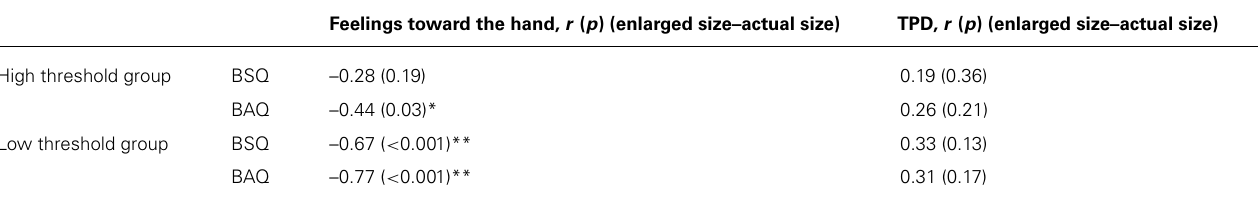
Table 3 | Correlation among BSQ score, BAQ score, variation of Feelings toward the hand, andTPD in both the high threshold and low threshold groups. Feelings toward the hand, r ( p ) (enlarged size–actual